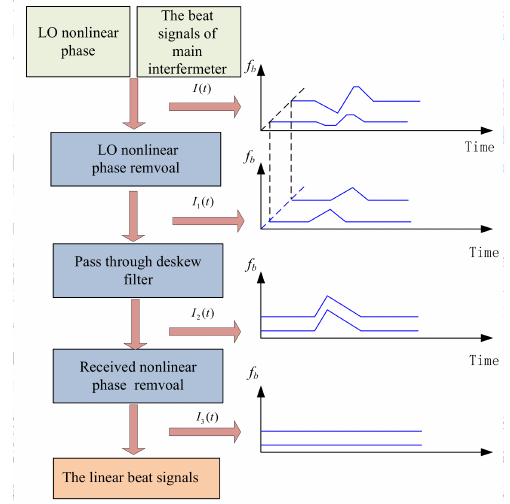
Figure 8. Signal processing procedure of the nonlinear phase compensation algorithm based on optimized deskew filter method (reprinted from Ding et al. [34] with permission of SPIE; copyright